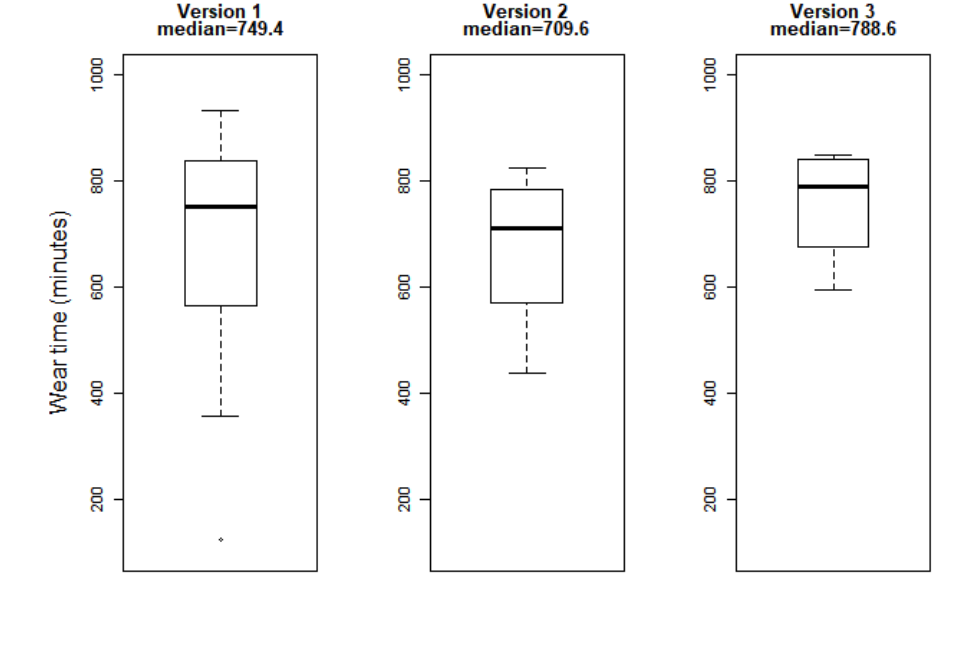
Figure 4. Median wear time (minutes per day) over 3 consecutive design-feedback